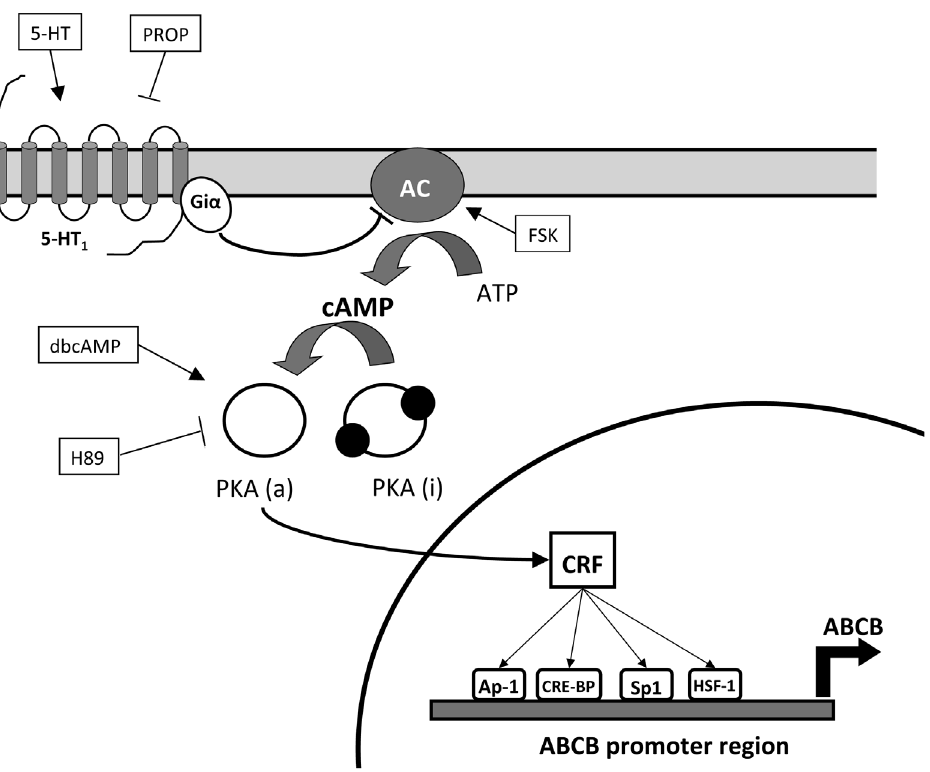
Figure 8. Schematic representation of the cAMP-dependent pathway leading to ABCB transcriptional regulation in mussel haemocytes. 5-HT 1 : type 1 serotonin receptor; 5-HT: serotonin; PROP: propranolol; Gi: inhibitory G-protein; AC: adenylyl cyclase; FSK: forskolin; cAMP: cyclic-AMP; PKA(i): inactivated cAMP-dependent protein kinase (PKA); PKA(a): activated PKA (catalytic subunit); dbcAMP: dybutyril cAMP; H89: N-[2-((p-Bromocinnamyl)amino)ethyl]-5-isoquinolinesulfonamide dihydrochloride; CRF: cAMP-responsive factors.